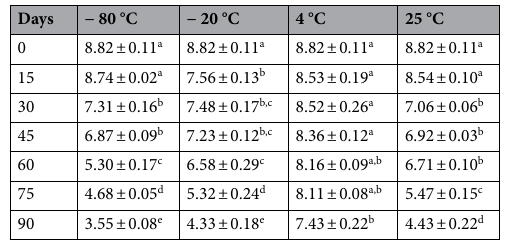
Table 2. Viability of Shigella virus 2019SD1 stored at varying temperature regimens. Values (PFU mL −1 ) of a given phage without common letter differ significantly at p ≤ 0.05 as per the Tukey’s HSD test. ± SEM (n=3).